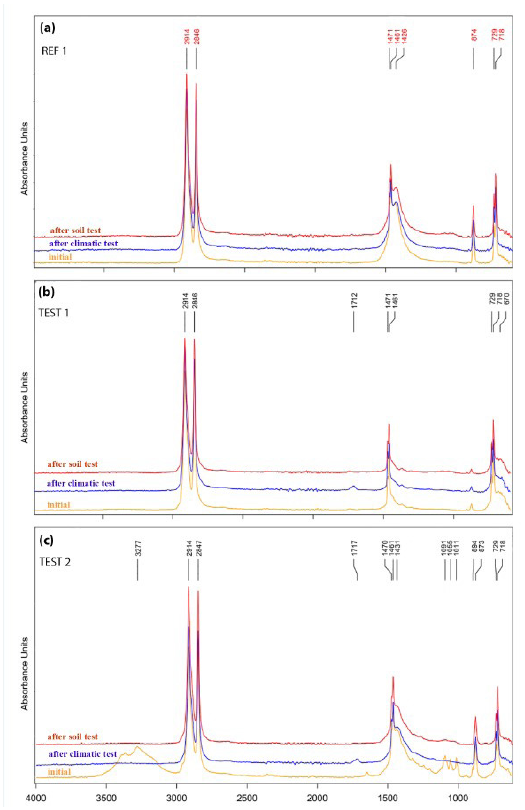
Figure 5. FTIR spectra of TEST 3 (a), TEST 4 (b), and TEST 5 (c) samples after the biodegradation test in soil and after the climatic test compared to the initial